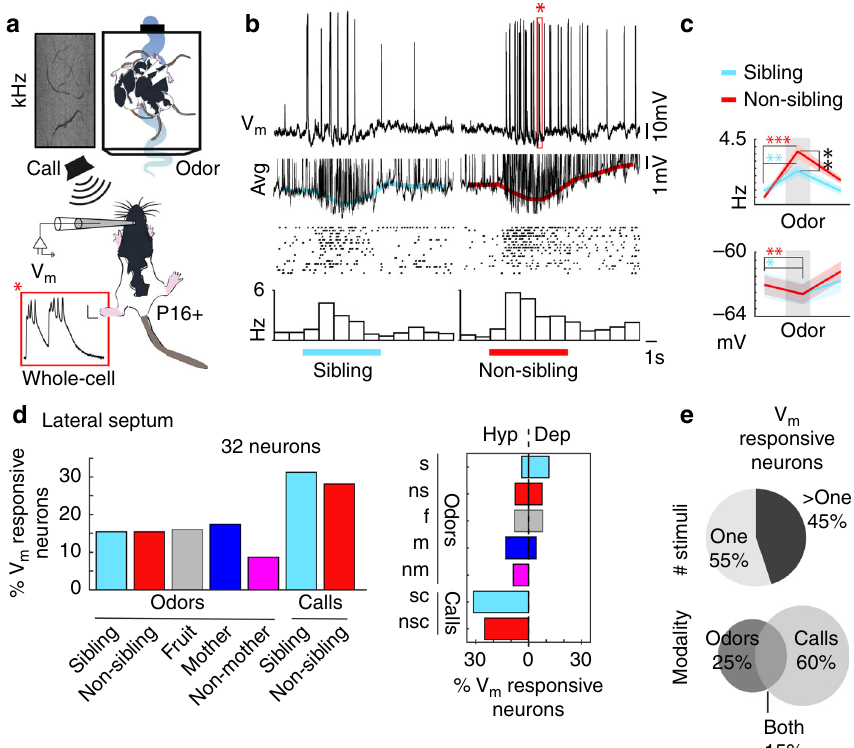
Fig. 6 Subthreshold responses of lateral septum neurons to kin stimuli. a Patch-clamp recordings of anaesthetized P16 + pups with odor and vocalization stimuli. Inset: plateau potential, scale bar: 10 mV/10 ms, from example in b (star). b Top: Membrane potential (V m ) example; below: average V m across trials, colored lines: average V m after spike removal; middle: raster; bottom: peristimulus time histogram. Colored lines: timing of odor. c Top: Spike rate, sibling odor ( n = 16 trials; mean ± s.e.m.; baseline = 0.94 ± 0.25 Hz; odor = 2.34 ± 0.35 Hz; difference = 1.40 ± 0.44; p = 0.006, paired t -test), and non- sibling odor ( n = 16 trials; mean ± s.e.m.; baseline = 0.50 ± 0.13 Hz; odor = 3.66 ± 0.51 Hz; difference = 3.16 ± 0.47; p = 6.7e − 6, paired t -test). Rate difference: sibling vs. non-sibling ( n = 16 trials; difference mean ± s.e.m. = 1.33 ± 0.43; p = 0.007, paired t -test). Bottom: V m response sibling odor ( n = 16 trials; mean ± s.e.m.; baseline = − 62.06 ± 0.79 mV; odor = − 62.59 ± 0.66 mV; difference = 0.53 ± 0.21; p = 0.021, paired t -test), and non-sibling odor